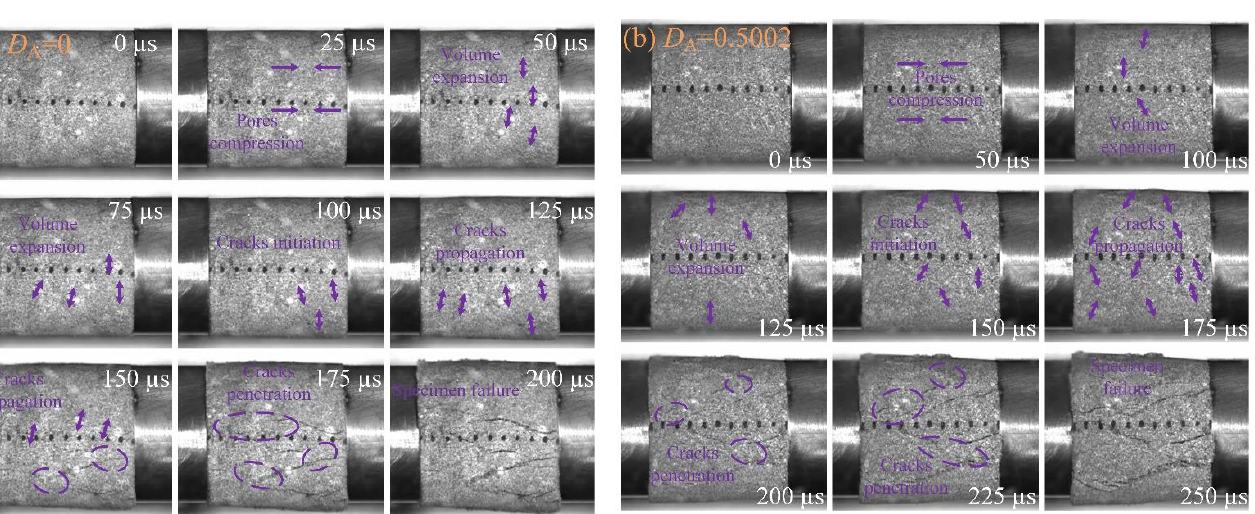
= 0 D ; ( b ) = 0; ( b ) D A A